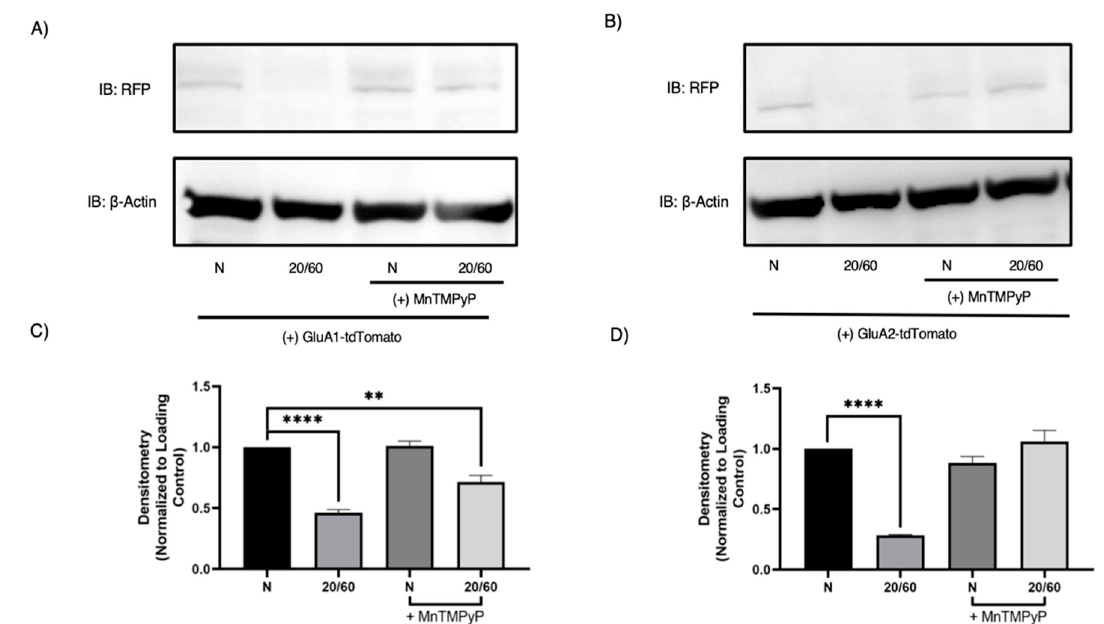
Figure 7. MnTMPyP prevented OGD/R-induced degradation of GluA1 and GluA2 AMPAR subunits. U-251 MG cells transfected with GluA1-tdTomato or GluA2-tdTomato and exposed to either normoxic or OGD/R conditions. ( A ) Representative Western blot demonstrating that pretreatment with MnTMPyP ameliorated OGD/R-induced decrease in total GluA1